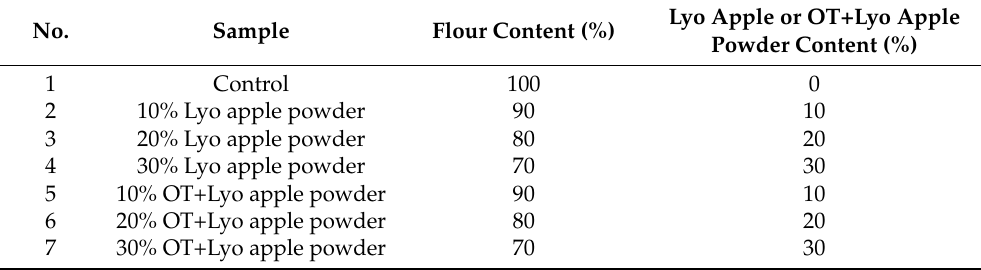
Table 1. Muffin samples’ compositions.